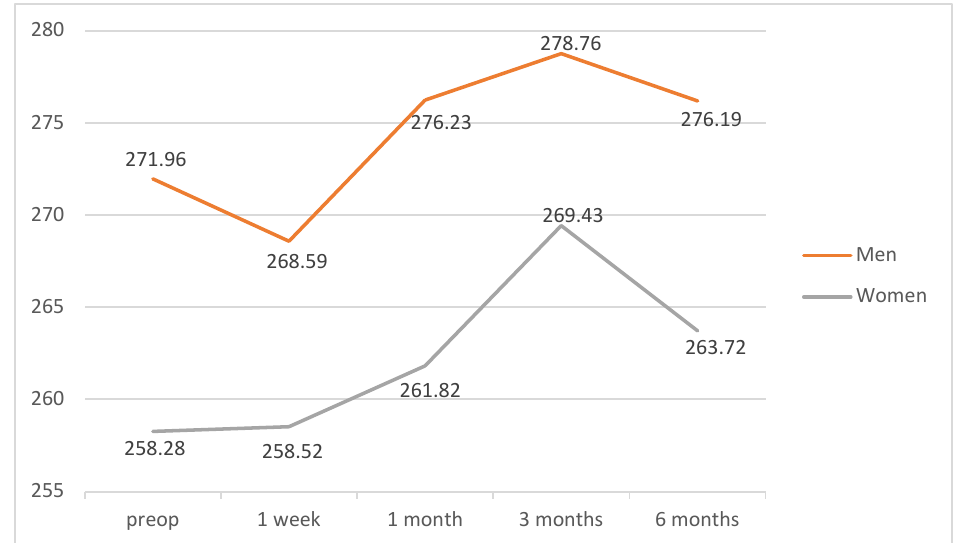
Figure 5. Mean values of the retinal thicknesses in the central 1 mm ring of the ETDRS grid for DM patients and non-diabetic subjects grouped by gender during the follow-up time points. Values are expressed in microns.